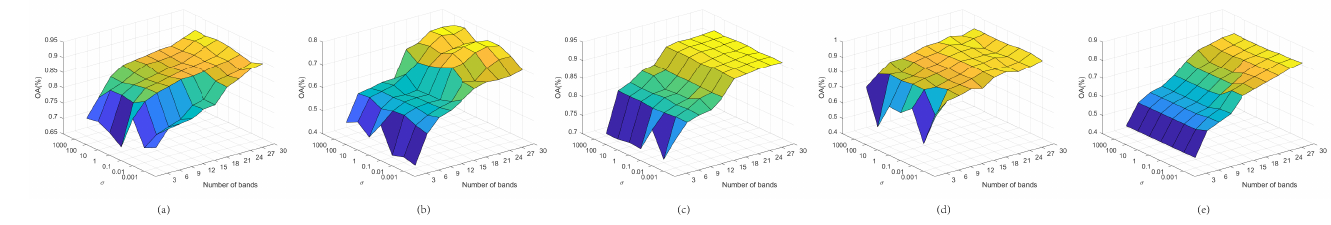
Figure 14. The sensitivity of hyperparameter, the number of groups, on the five datasets. ( a ) Pavia University; ( b ) Indian Pines; ( c ) Salinas; ( d ) Botswana; ( e ) Houston University.